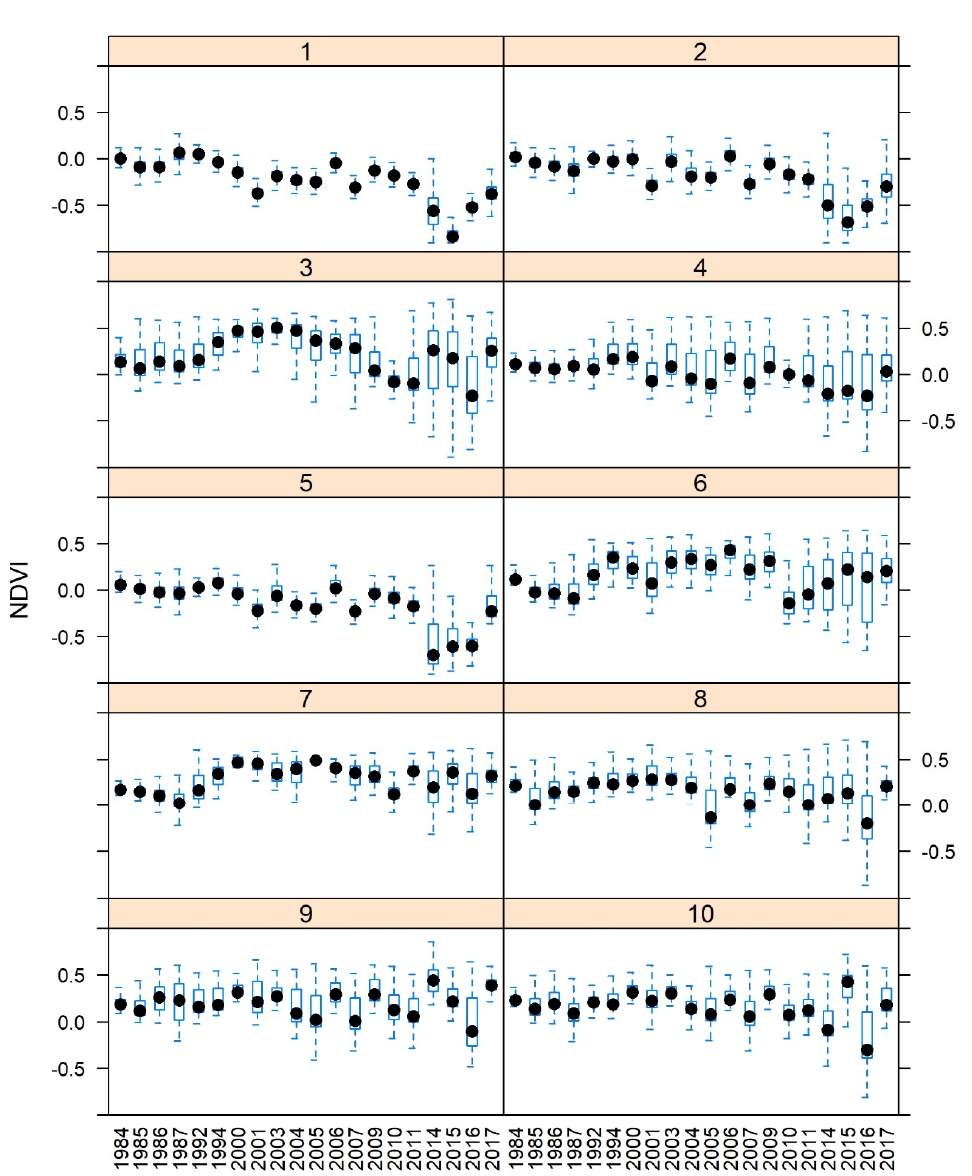
Figure 6. NDVI values for waterbodies (MNDWI ≥ 0) within the 10 basins of Lake Tisza between 1984 and 2017.